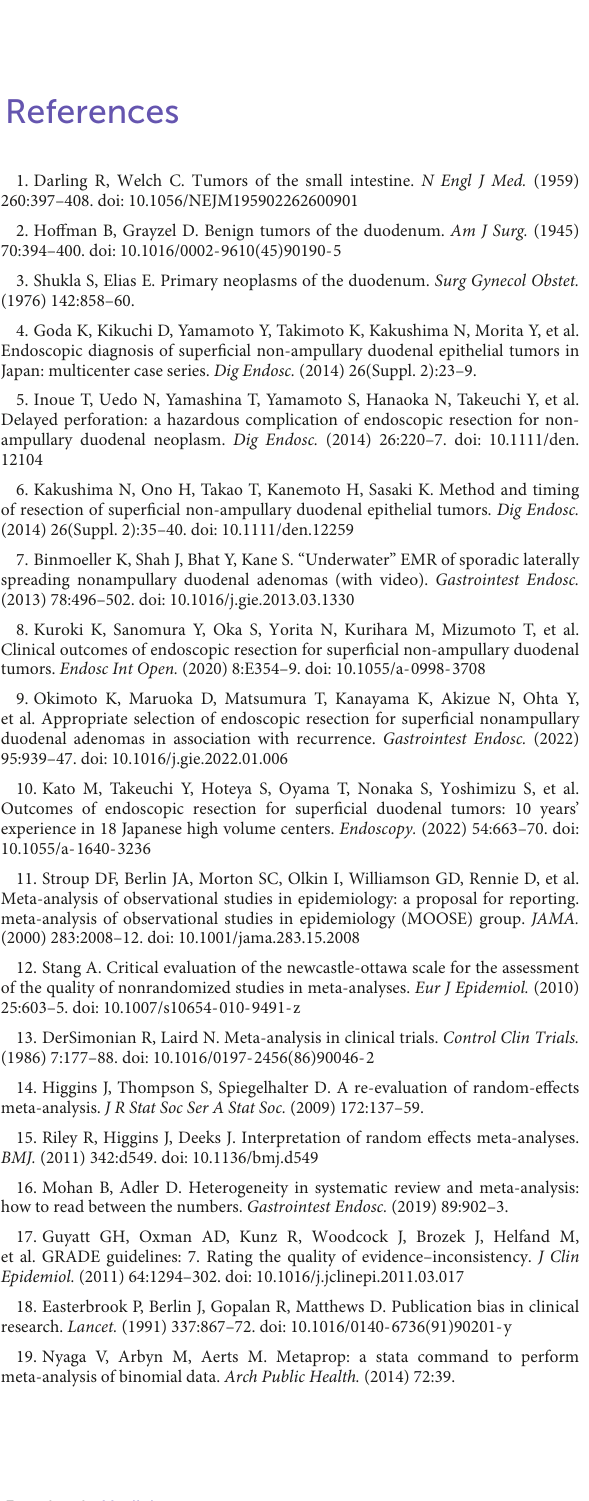
SUPPLEMENTARYFIGURE4 Forest plot, en-bloc resection rate, subgroup analysis according to sample size. SUPPLEMENTARYFIGURE5 Forest plot, R0 resection rate, subgroup analysis according to sample